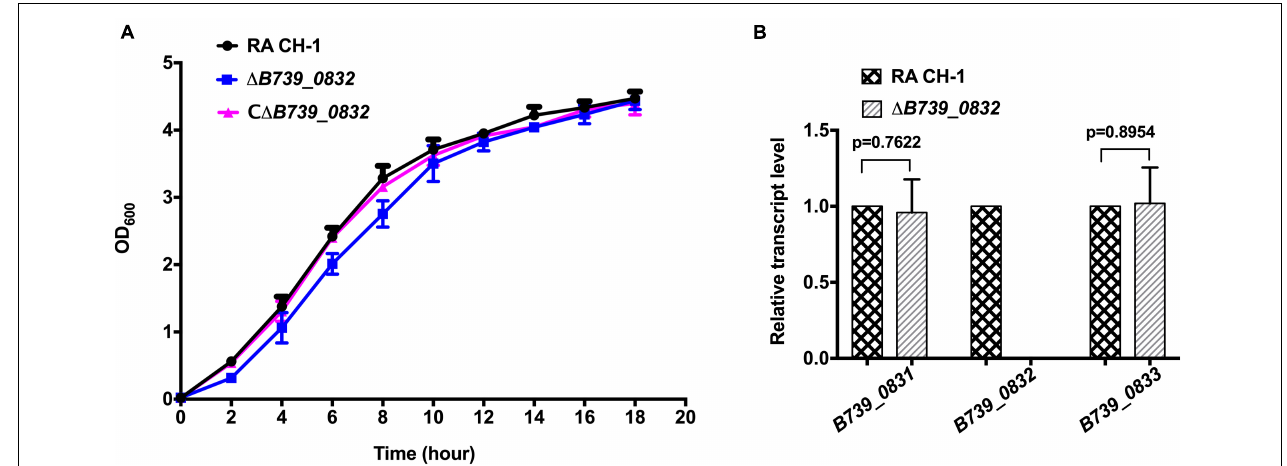
FIGURE 1 | Characterization of mutant strain (cid:49) B739_0832 and complemented strain C (cid:49) B739_0832 . (A) Growth curves of Riemerella anatipestifer CH-1, (cid:49) B739_0832 , and C (cid:49) B739_0832 strains in Tryptic Soy Broth (TSB). Cells were inoculated in 25 ml of fresh TSB at 37 ◦ C with an initial OD 600 of 0.05. OD 600 values for each culture were subsequently measured every 2 h for 18 h. Data represent the mean values of three experiments. (B) Gene transcription levels in (cid:49) B739_0832 strain were analyzed using quantitative PCR (qPCR). Transcription levels of B739_0832 and the flanking genes B739_0831 and B739_0833 in R. anatipestifer CH-1 and (cid:49) B739_0832 strains were measured. Expression of B739_0832 was completely inactivated in the (cid:49) B739_0832 mutant strain. Expression of upstream gene B739_0831 and downstream gene B739_0833 had no significant difference compared to wild type. Data were analyzed using Student’s t -test. Error bars represent standard deviations of three independent repeats.